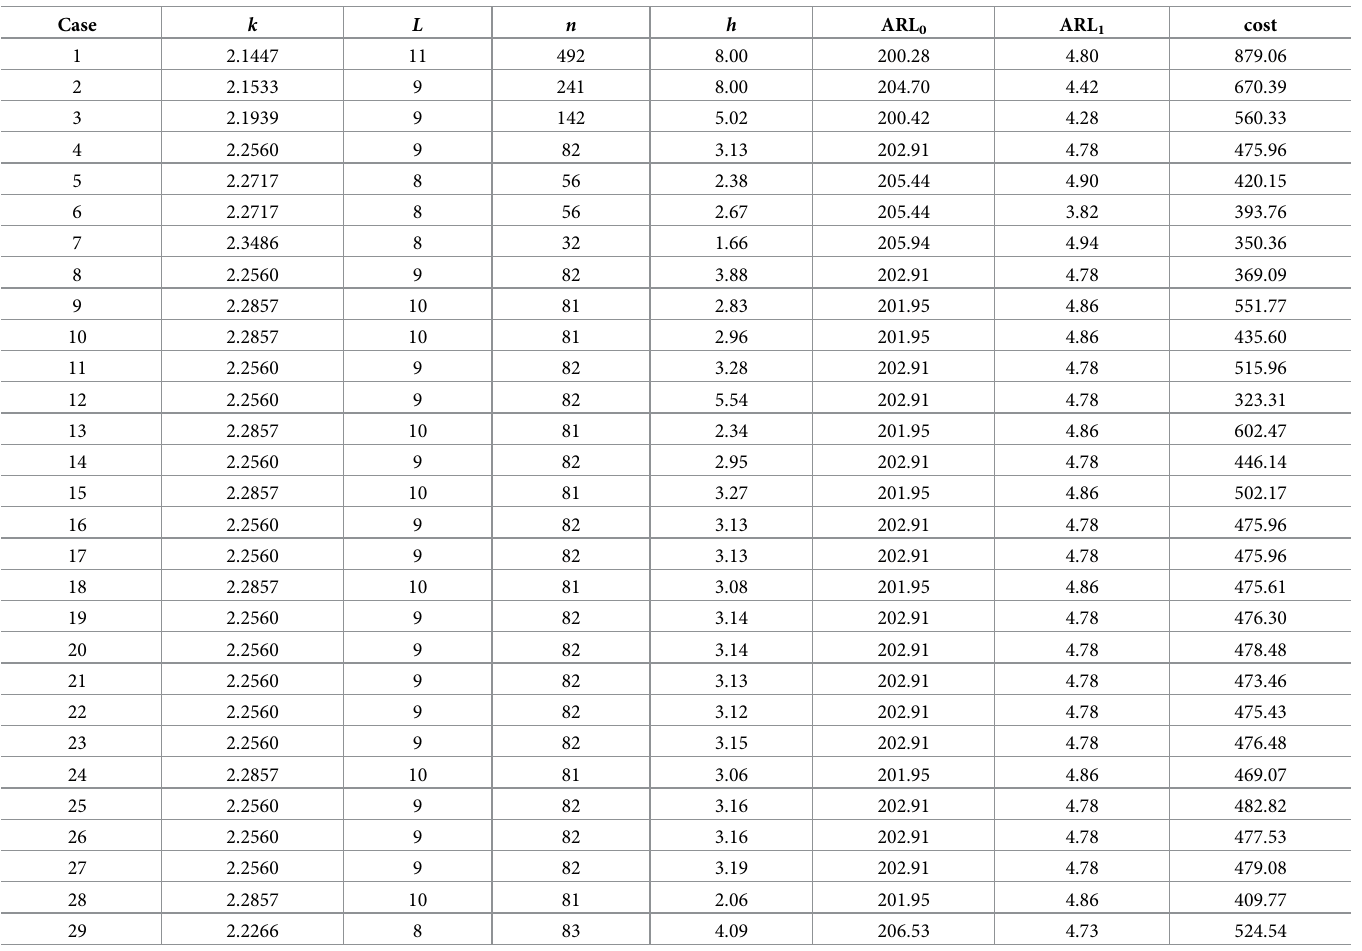
Table 2. Optimal chart parameters and the corresponding ARL 0 , ARL 1 and expected cost of the economic-statistical design of the synthetic np chart with known process